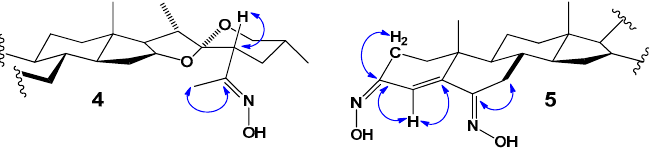
Figure 2. HMBC correlations for the oxime ( 4 ) and dioxime ( 5 ).